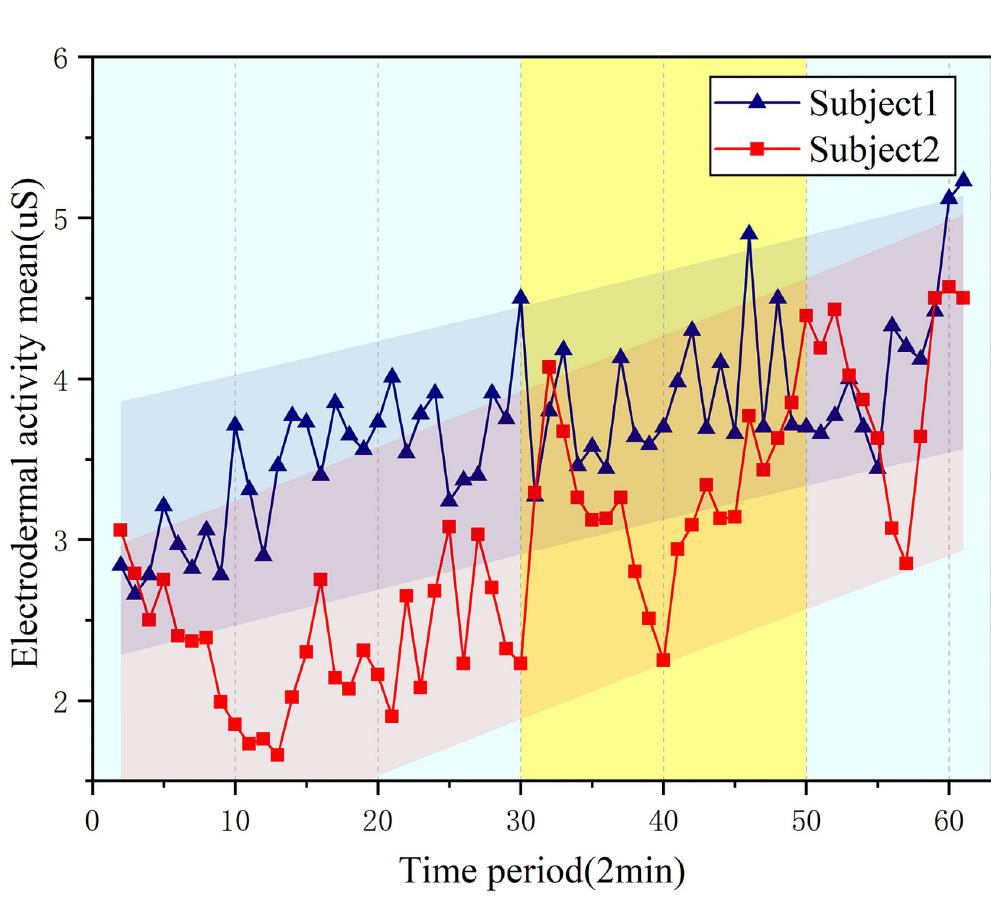
Fig 14. Trend of mean value of EDA signal.